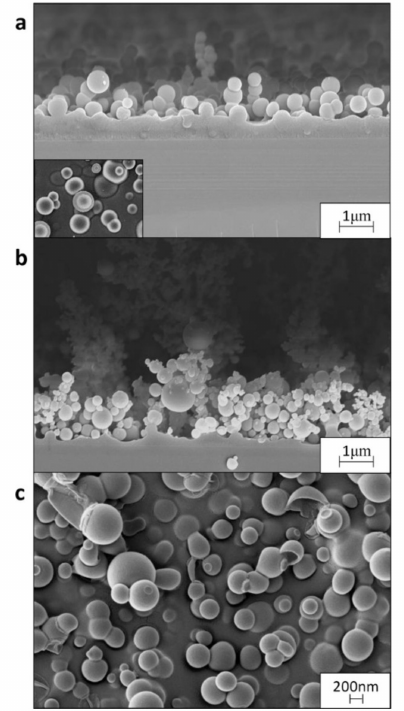
Figure 15. Cross-sectional SEM images of plasma-deposited coatings (20sccm ethylene, 5slm He, 15mg / ml of vancomycin solution) in ( a ) continuous mode (CM, inset top view) and ( b ) pulse mode condition. ( c ) Top view: SEM image of a CM plasma-deposited coating after 60 min immersion in water. Reprinted with permission from [74]. Copyright 2006 John Wiley & Sons,